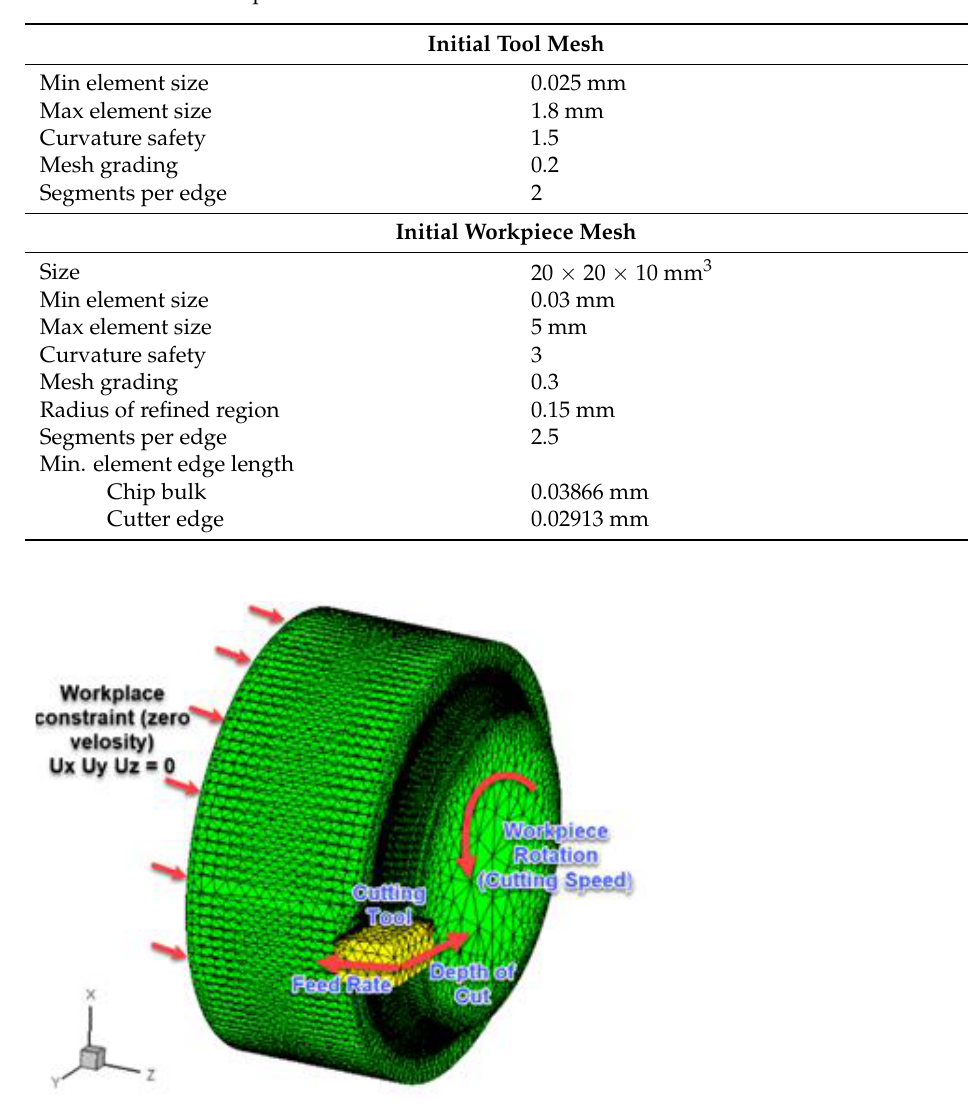
Table 6. The mesh setup.